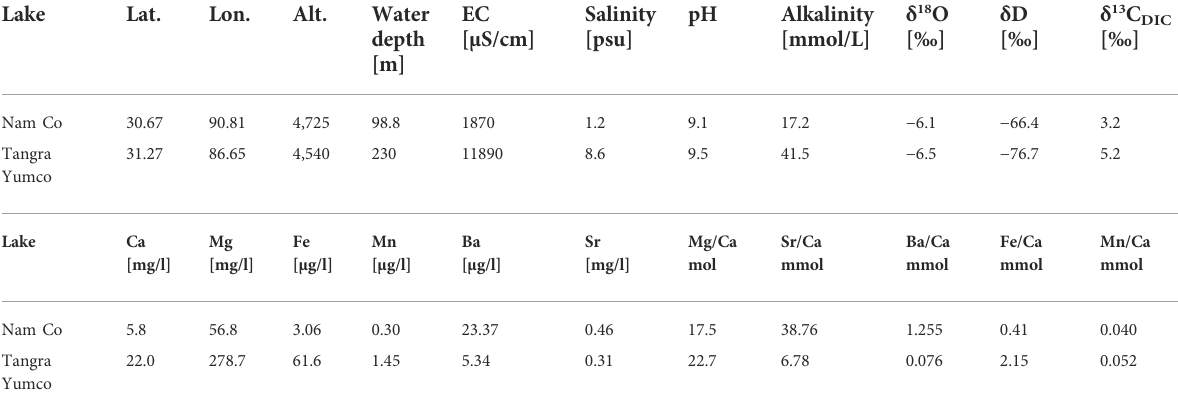
TABLE 1 Characteristics of modern lake waters of both studied lakes Nam Co and Tangra Yumco. Lake